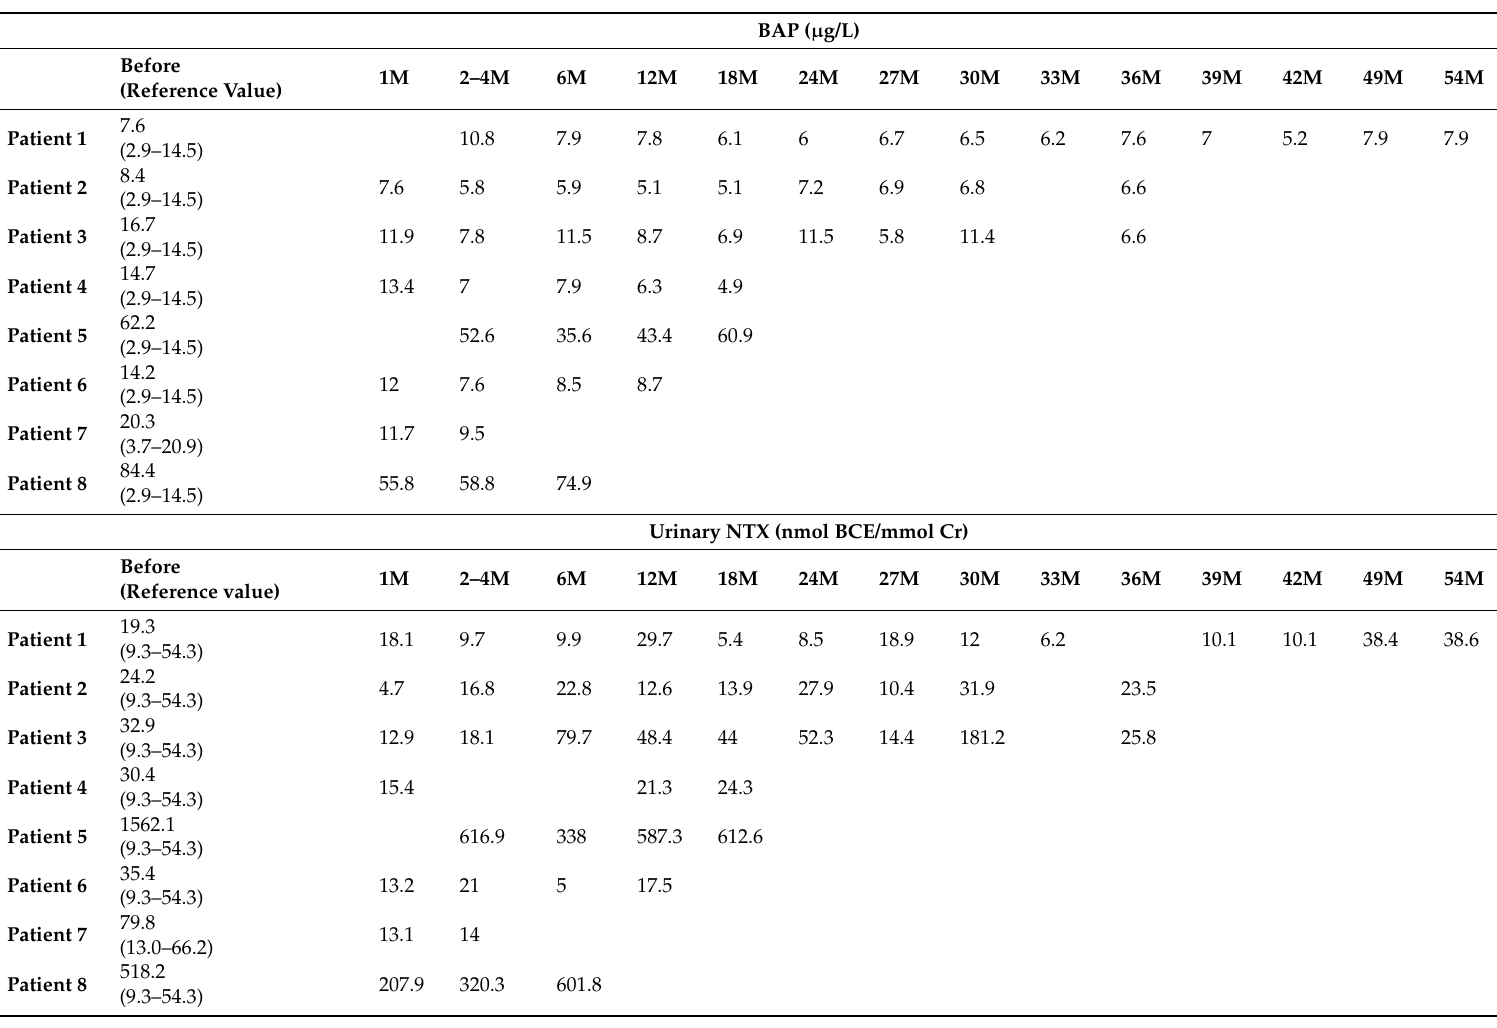
Table 4. Patient laboratory data (bone metabolism markers) across observation periods for each